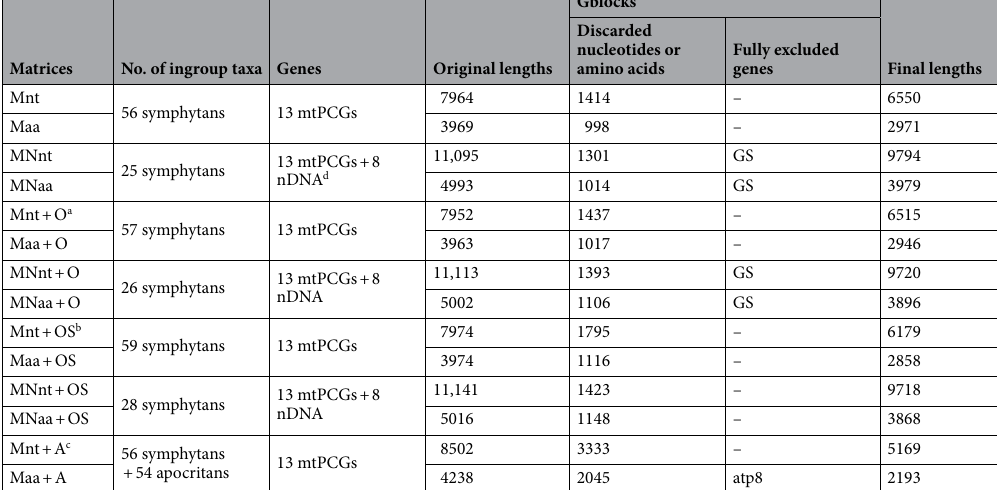
Table 3. Characteristics of fourteen nucleotide sequence and amino acid sequence matrices used in the current phylogenetic analyses, consisting of mtgenomes only or mtgenomes plus eight nDNAs. a Inclusion of Orussoidea. b Inclusion of Siricoidea. c Inclusion of Apocrita. d CAD, GLN, GS, IDH, NAK, PGD, POL, and TPI (see Malm and Nyman 16 for the detailed